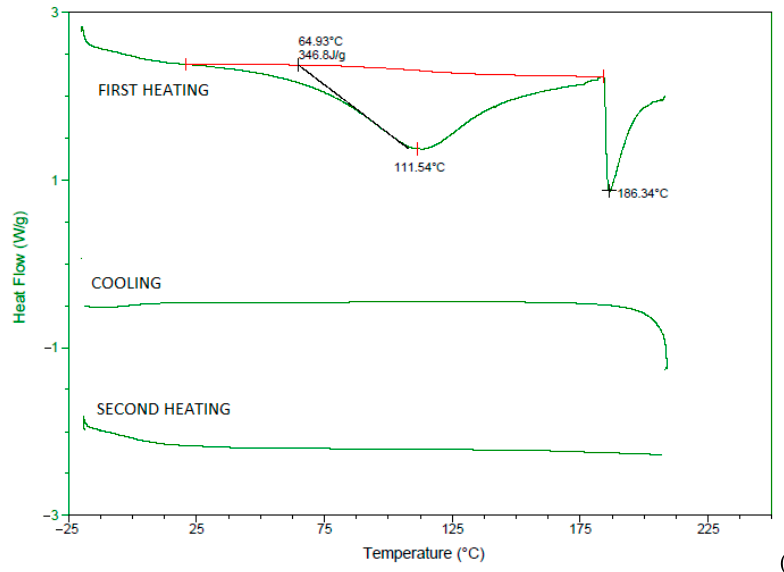
Figure 4. Differential scanning calorimetry (DSC) results for ( a ) 20%, ( b ) 40%, and ( c ) 60% HA integration within the SA hydrogels.